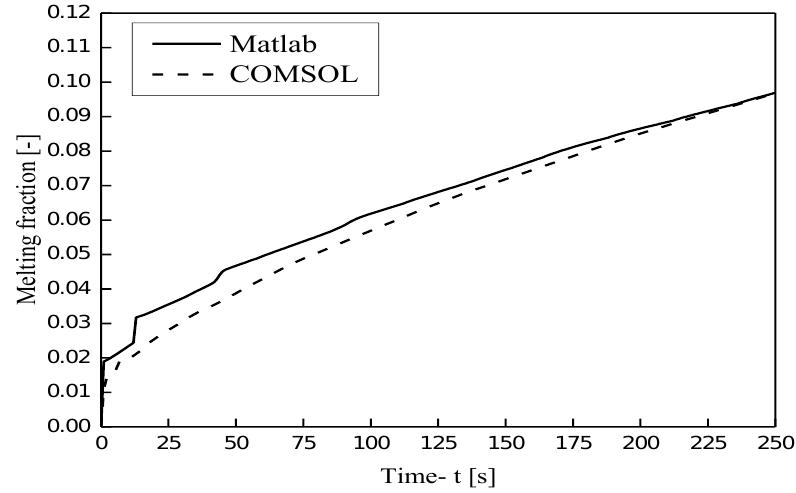
Figure 8. Melting fraction evolution for RT50.